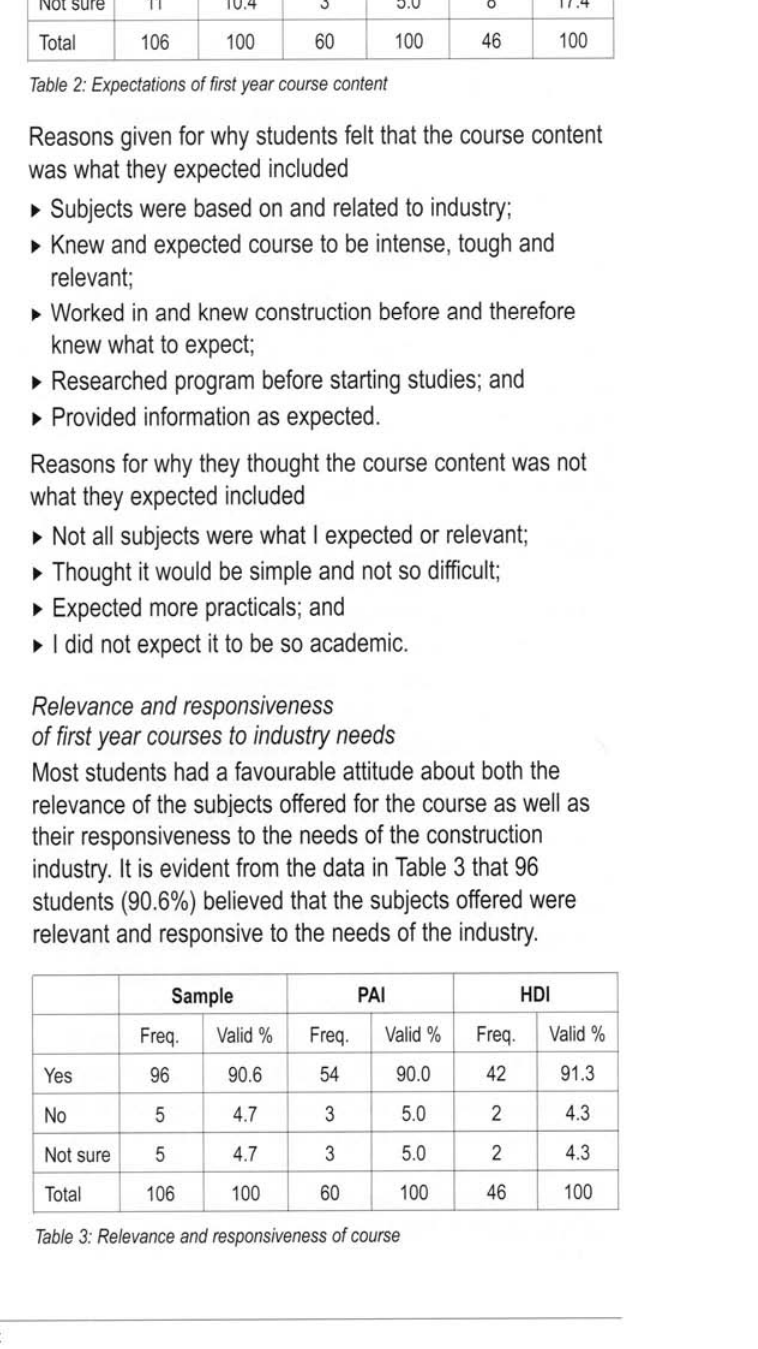
Table 2: Expectations of first year course content